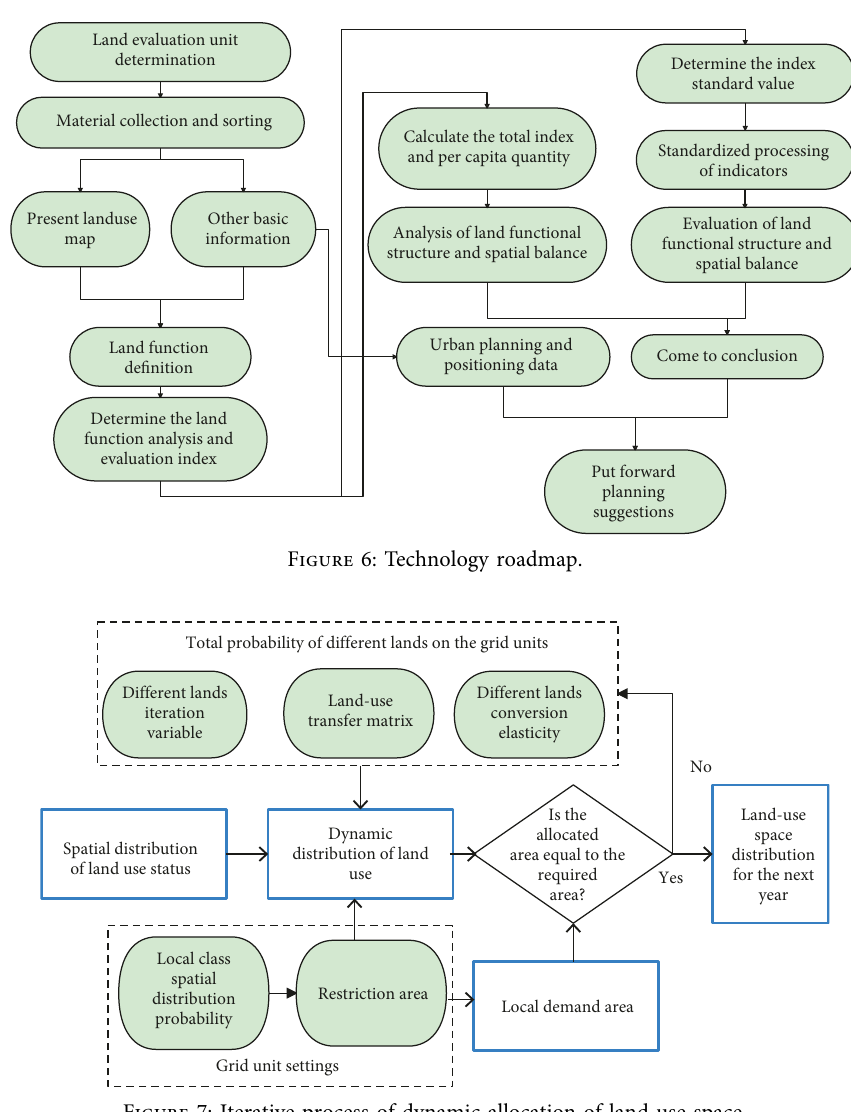
Figure 7: Iterative process of dynamic allocation of land use